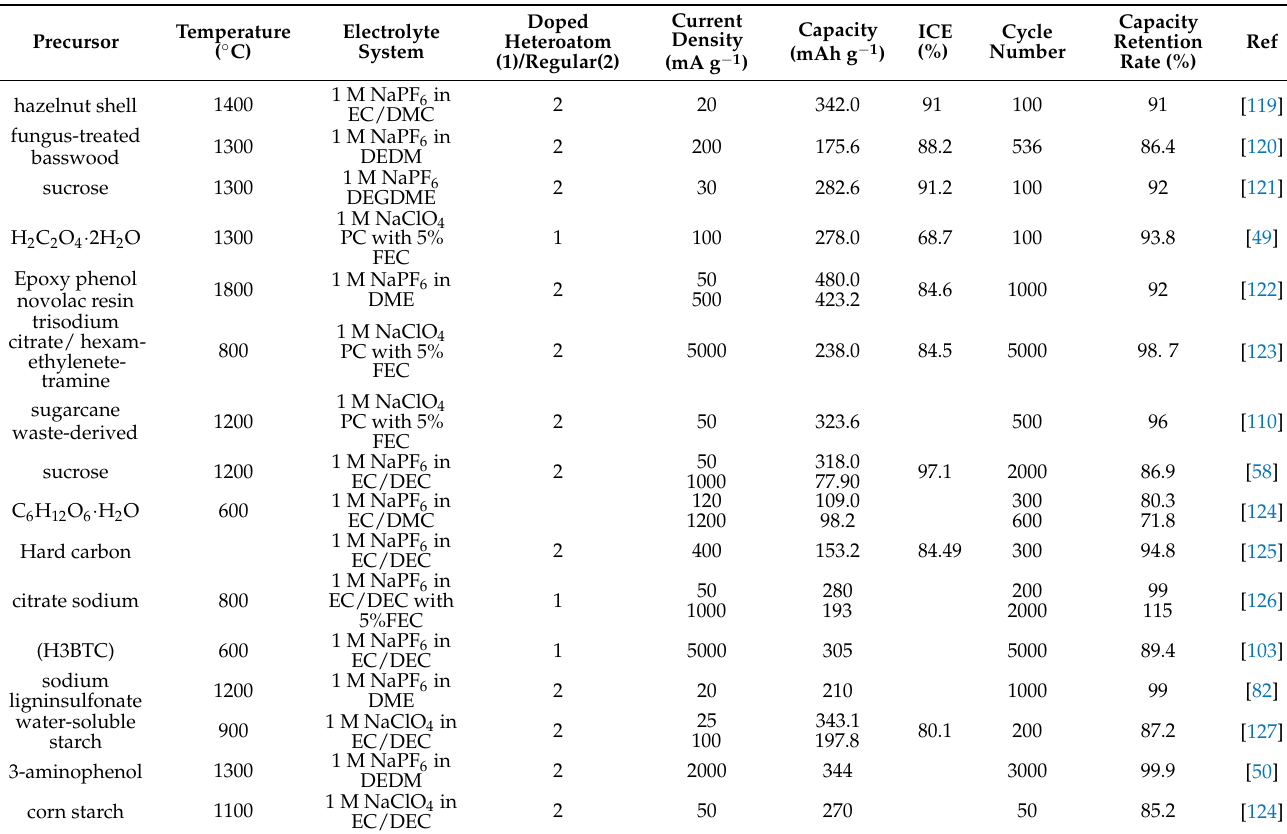
Table 1. Summary of representative publications on hard carbon as a SIB